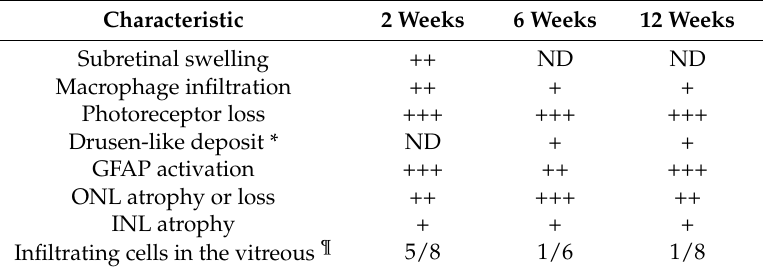
Table 2. Retinal and subretinal changes in Cre -injected mice.